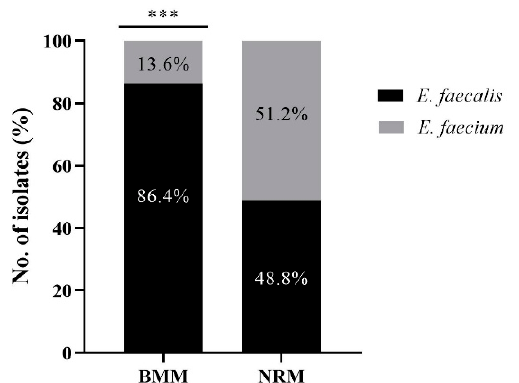
Figure 1. Comparison of the prevalence of Enterococcus faecalis and Enterococcus faecium isolates in bovine mastitis milk (BMM; n = 81) and bovine normal raw milk (NRM; n = 41). *** indicates significant difference in the prevalence rate of E. faecalis and E. faecium isolates in BMM ( p < 0.0001; Pearson’s chi-square test). BMM: bovine mastitis milk, NRM: bovine normal raw milk.